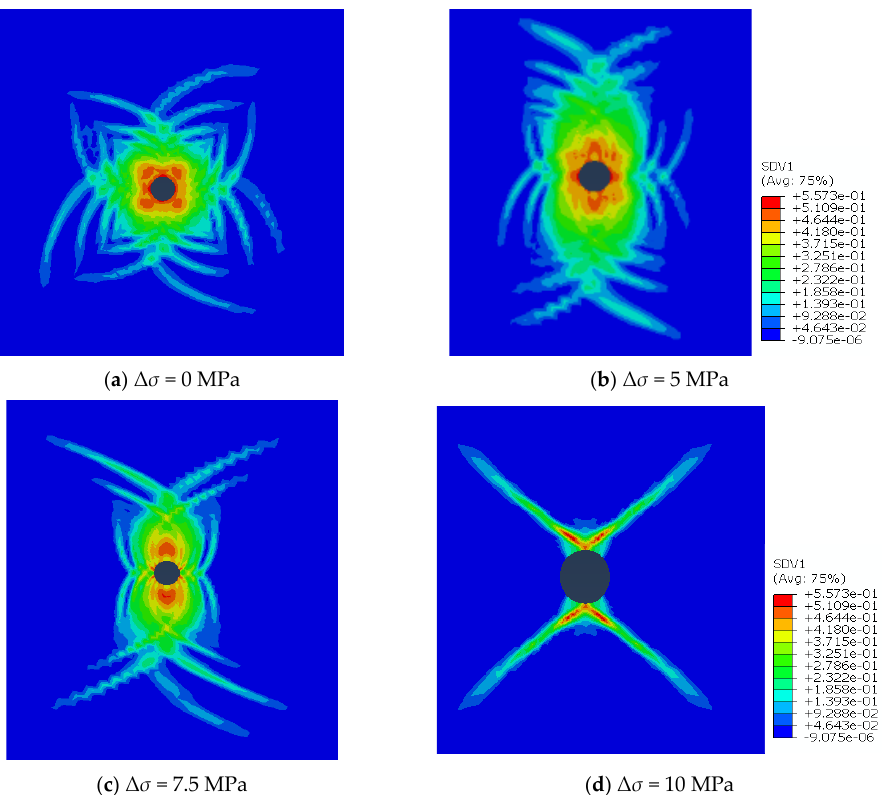
Figure 6. Evolution of equivalent plastic strain with the stress difference. The cloud picture of damage factor distribution around the borehole under different stress anisotropy is shown in Figure 7. As the stress anisotropy is enhanced, the rock dam- aged area in the x axis is narrowed and elongated in the y axis. As the stress anisotropy reduces, the bifurcation increases. Under the strong stress anisotropy of the stress differ- ence of 10 MPa, only one bifurcation occurs in the y axis, and the shear damage zone is generated along the 45° direction.